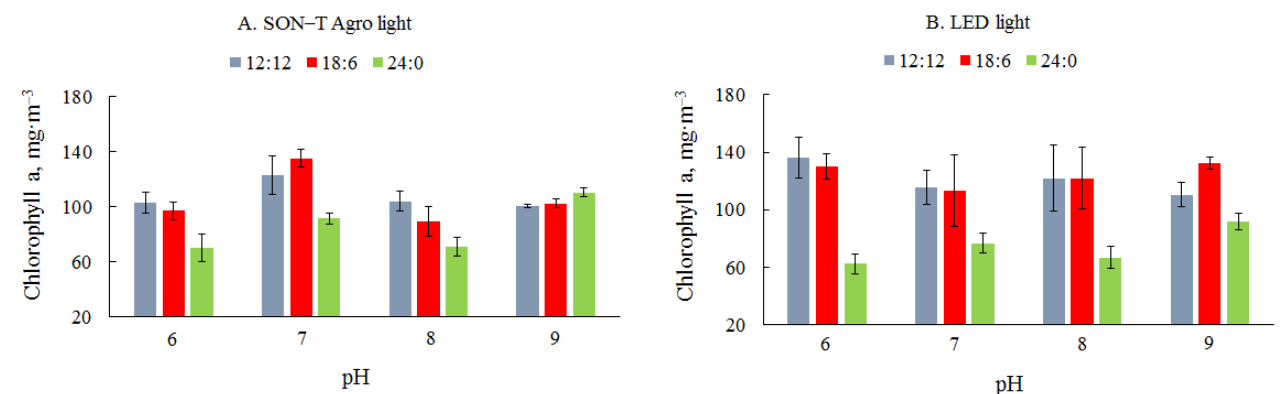
Figure 7. The average amount of chlorophyll a in microalgal biomass in ( A ) SON-T Agro light and ( B ) LED light during different light:dark cycle.